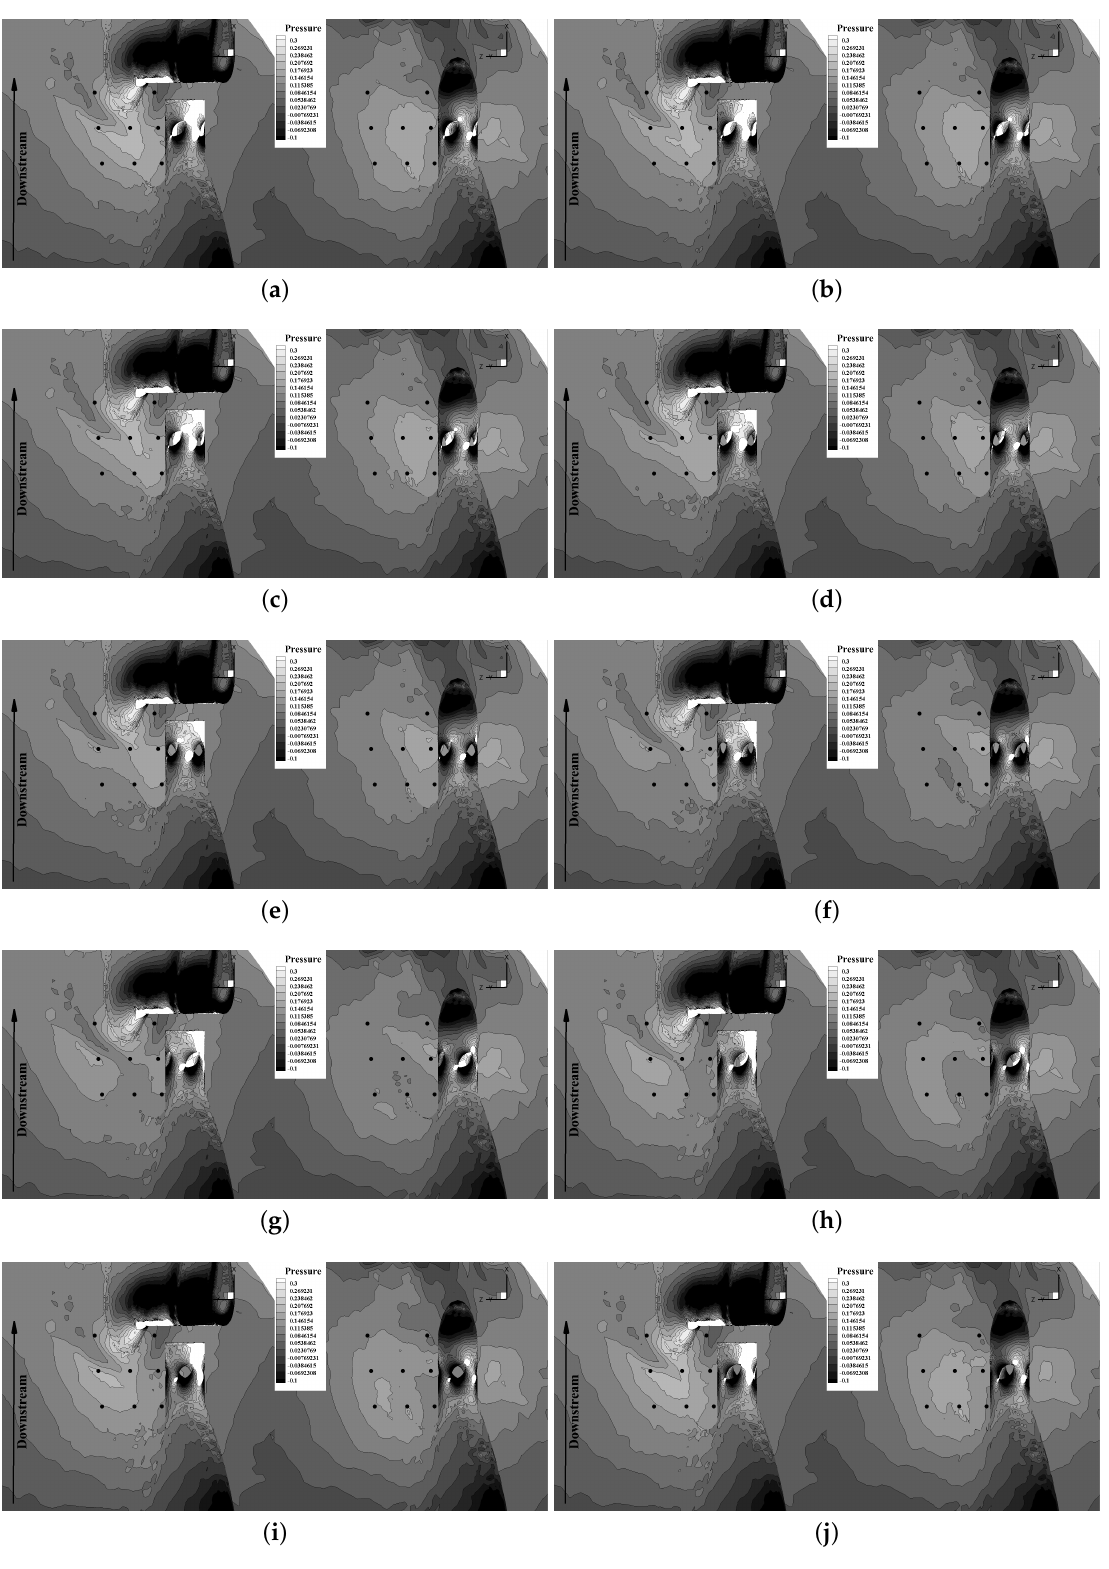
Figure 33. Contour plots of the fluctuating hull pressures (unit: N) at the key blade angle ( a ) θ = 0.0 ◦ , ( b ) θ = 5.8 ◦ , ( c ) θ = 11.6 ◦ , ( d ) θ = 17.4 ◦ , ( e ) θ = 23.2 ◦ , ( f ) θ = 34.8 ◦ , ( g ) θ = 46.4 ◦ , ( h ) θ = 58.0 ◦ , ( i ) θ = 69.6 ◦ , and ( j ) θ = 81.2 ◦ with/without rudder. Note fluid density in RANS is 1.0 kg/m 3 to be directly compared to the BEM results. Black scatters denote the transducer